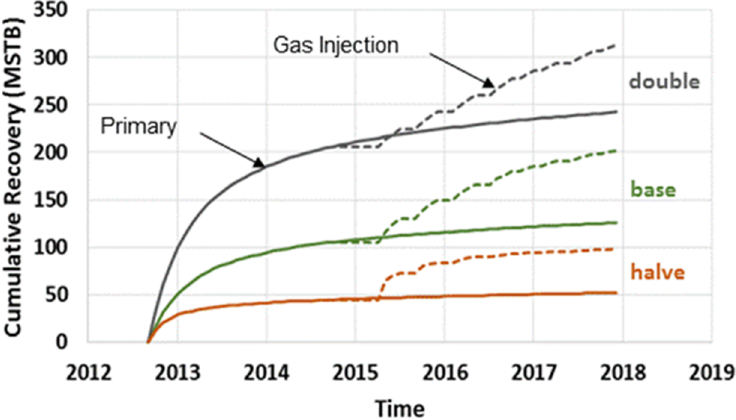
Figure 20. Cumulative recovery for primary and gas injection cases when models have different amounts of fracture surface area.